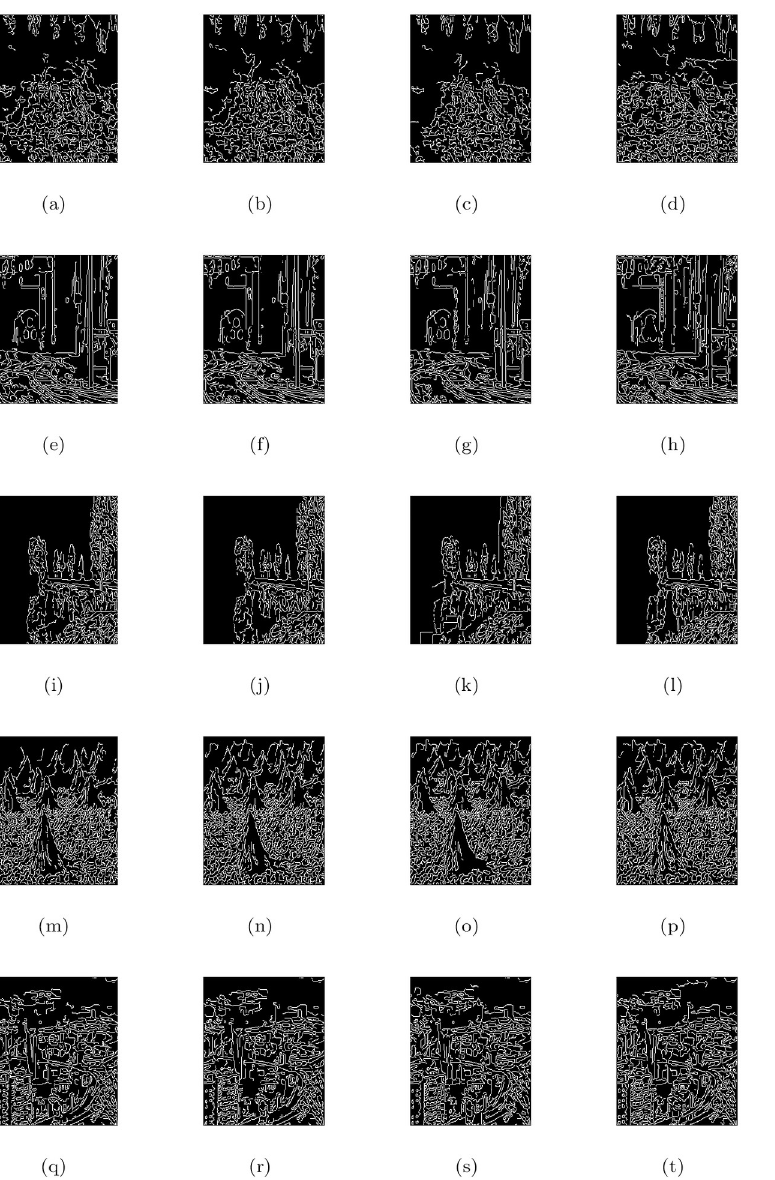
Fig 12. Corresponding visible edge maps of Fig